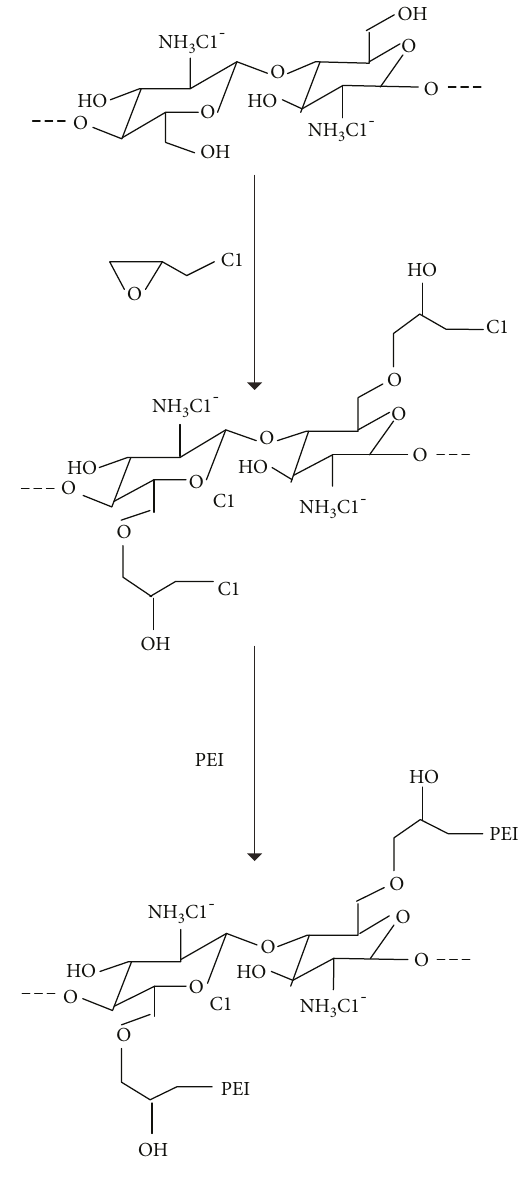
Figure 1: Reaction scheme of constructing